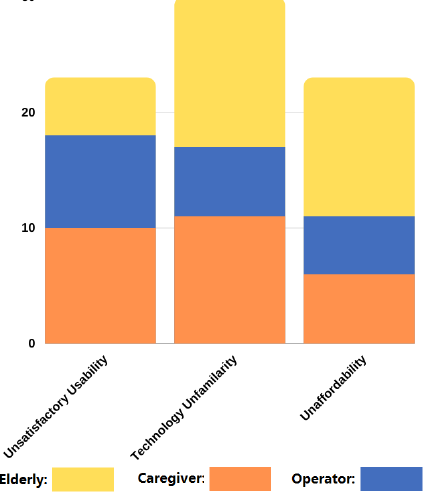
Figure 7. Technology acceptance barrier The managers of C5O1, C6O1, and C9O1 in the interview agreed that technology implementation assists QoL among the elderly